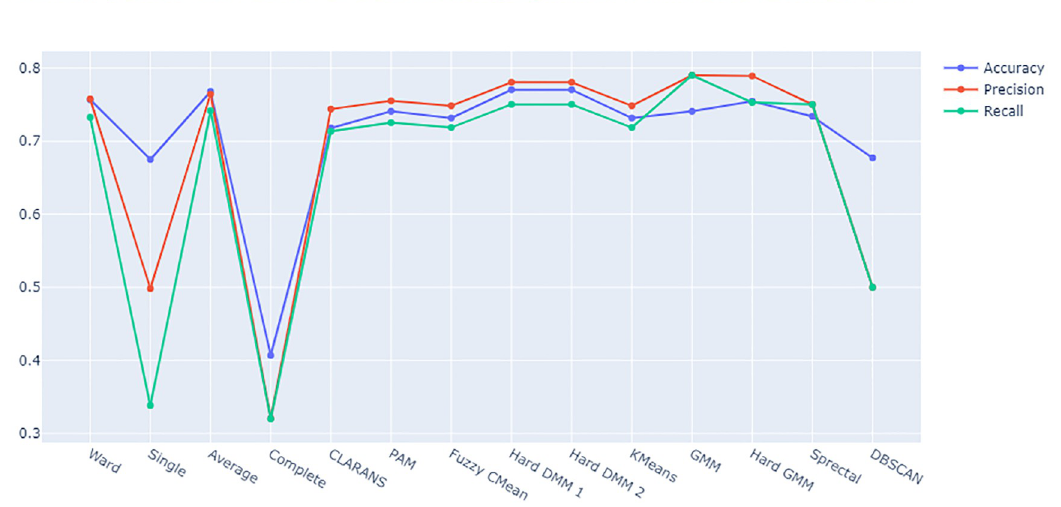
Fig 15. Plot of accuracy, precision and recall of different algorithms on on wholesale customers data.